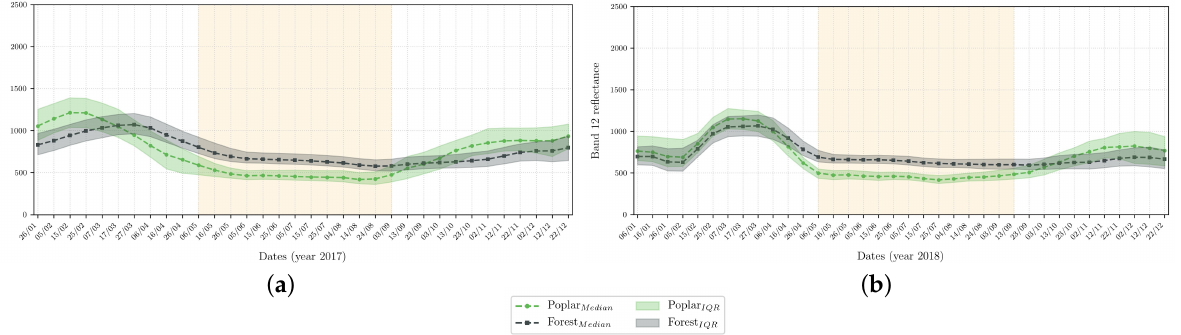
Figure A4. Temporal profile of band 12 reflectance in poplar plantations versus other deciduous tree species: in ( a ), the profile in 2017; in ( b ), the profile in 2018. Dashed lines refer to the median signal, and the surrounding shaded areas represent the interquartile range, shown in red for poplar and in grey for other deciduous species. The light yellow box highlights the most discriminating spring–summer period for poplars.